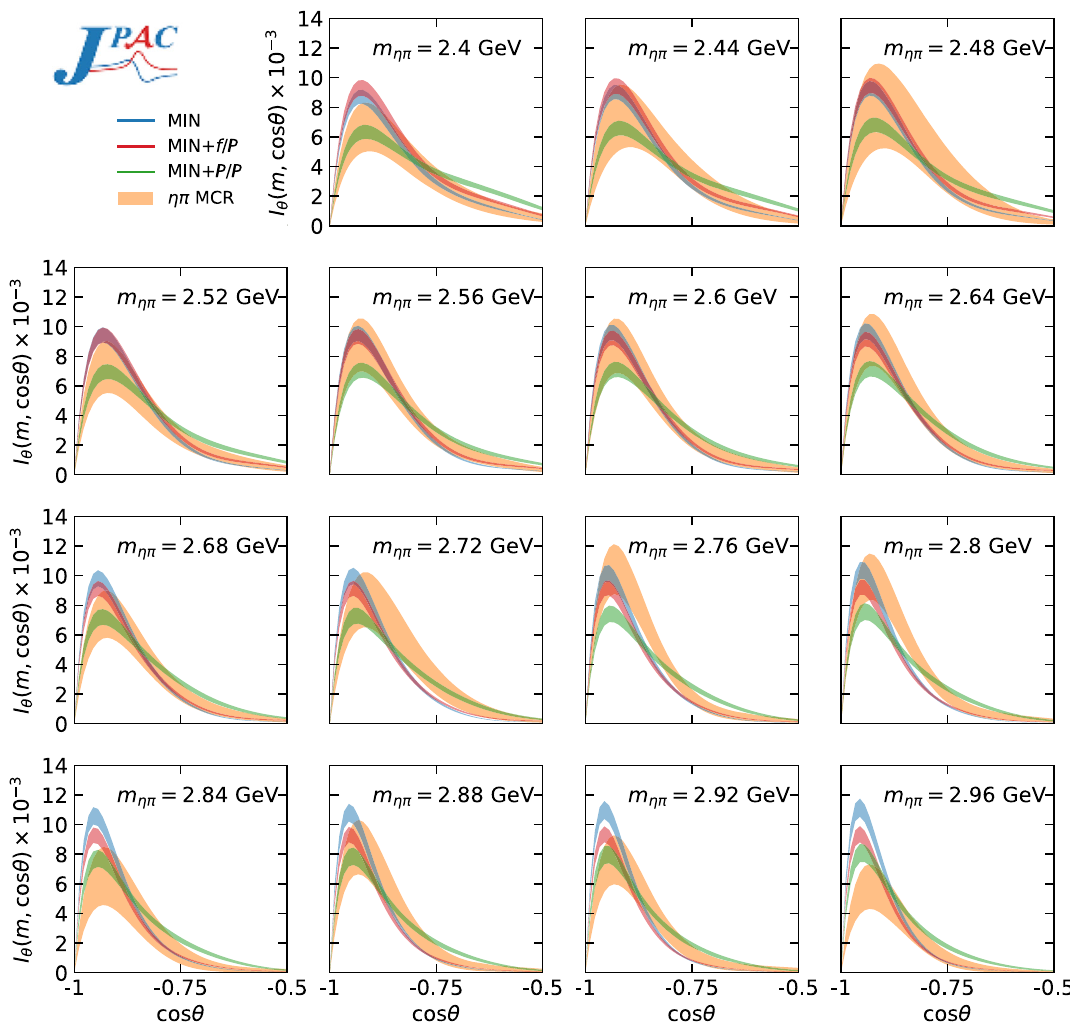
Fig. 13 Same as Fig. 12 for the ηπ backward region. Model differences are now apparent